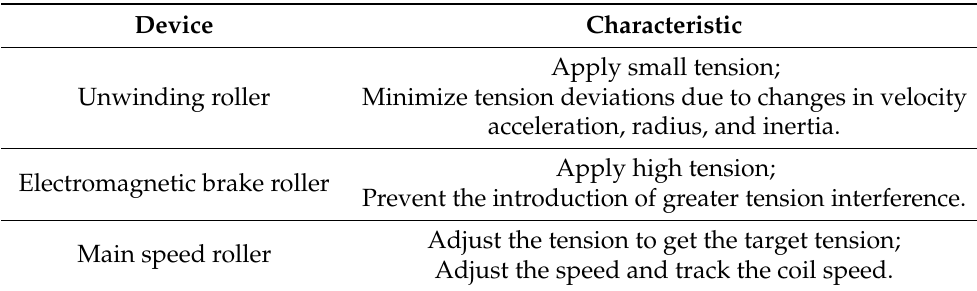
Figure 2. Main devices in the winding process of insulating tape. Table 1. Characteristics of three devices.